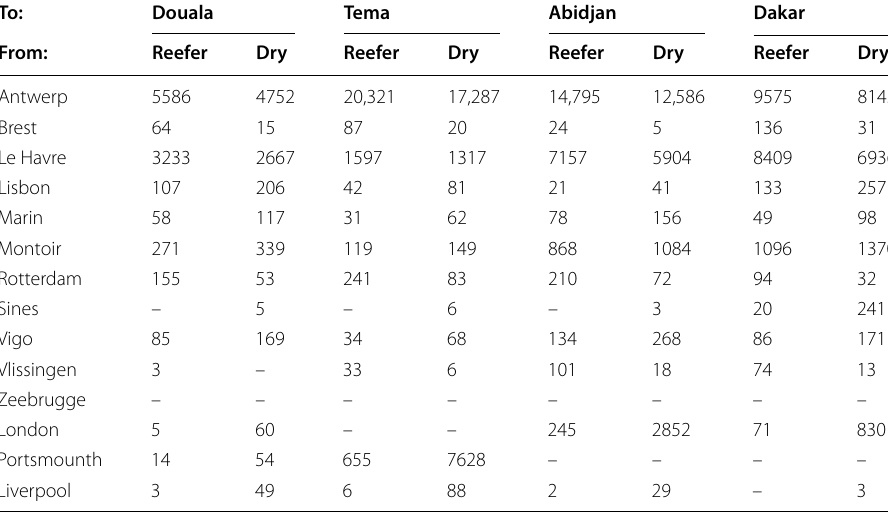
Table 6 Overview of the direct potential market [TEU] of dry and reefer transport from Europe to West-Africa